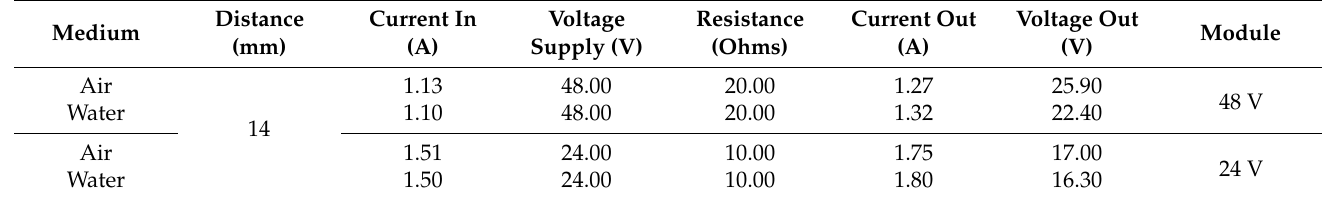
Figure 16. Experimental WCH validation in underwater environment: housings ready for testing ( a ) and housings being tested completely submerged ( b ). Table 14. Comparison between air and water: Electric parameters registered during testing of wireless modules power efficiency.